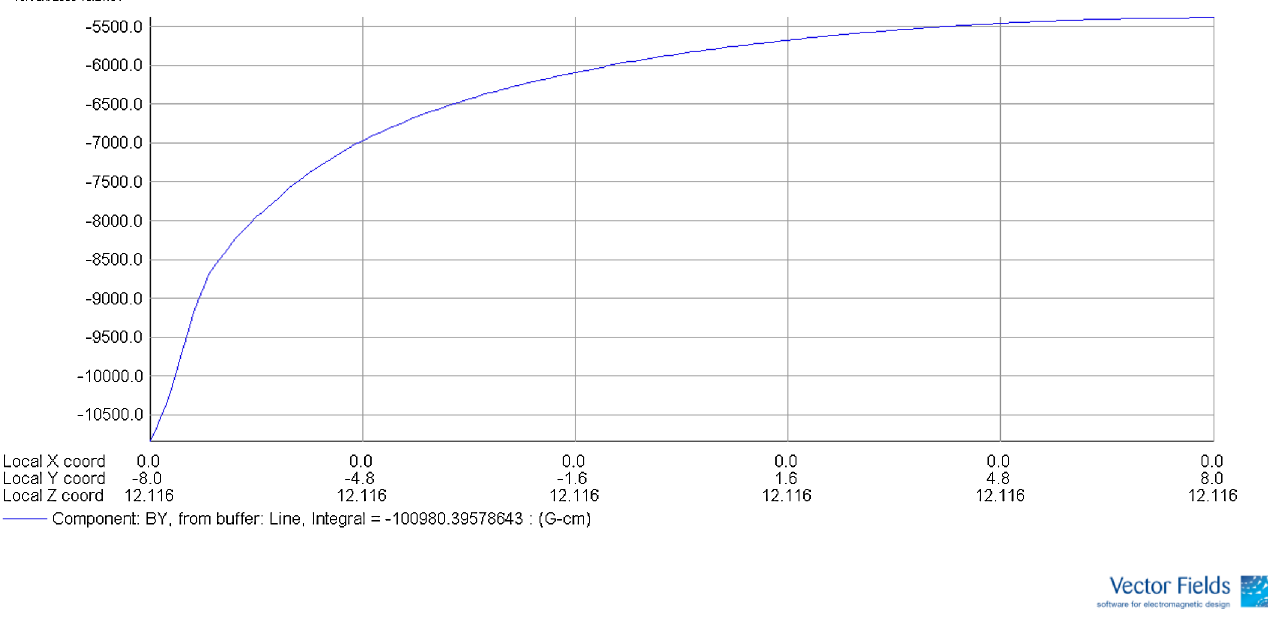
FIG. 15. (Color) B y vs y at x ¼ 0 and z ¼ 12 : 116 cm